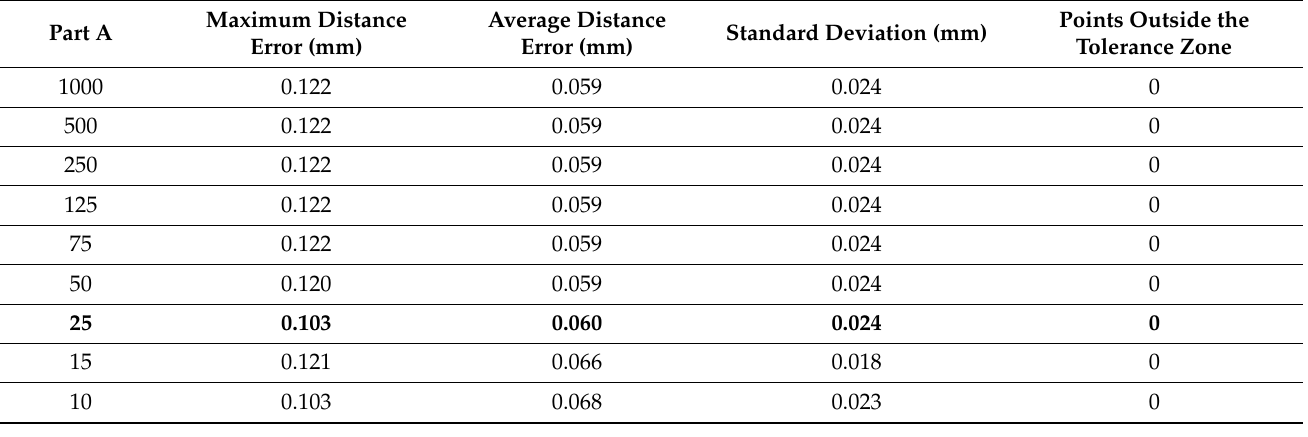
Table 2. Calculations of measured CMM points for one section and deviation to CAD B-Spline shape for vane example.